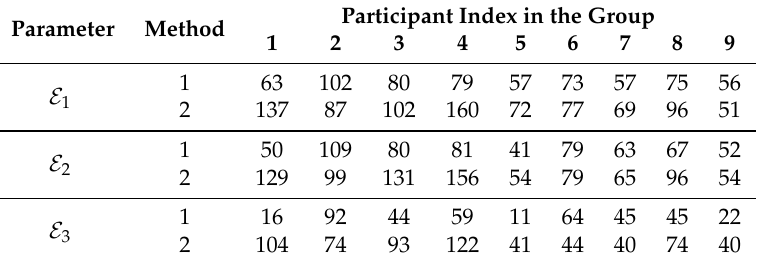
Table 3. E 1 , E 2 , and E 3 are parameters that evaluate teaching efficiency for the two methods of learning (method = 1 includes the classification process); the unit of all parameters is 1 mm.